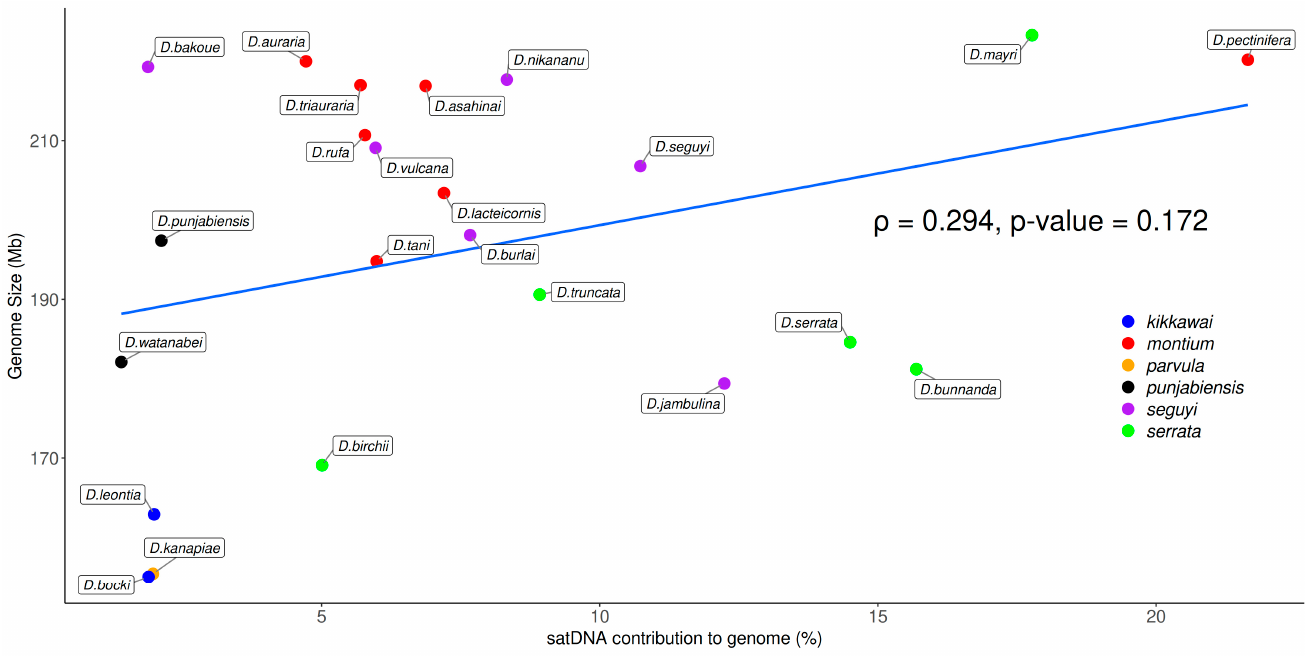
Figure 6. Correlation test between genome size and satDNAs contribution to genome in species from the montium group. The p value was obtained with Spearman’s correlation test.